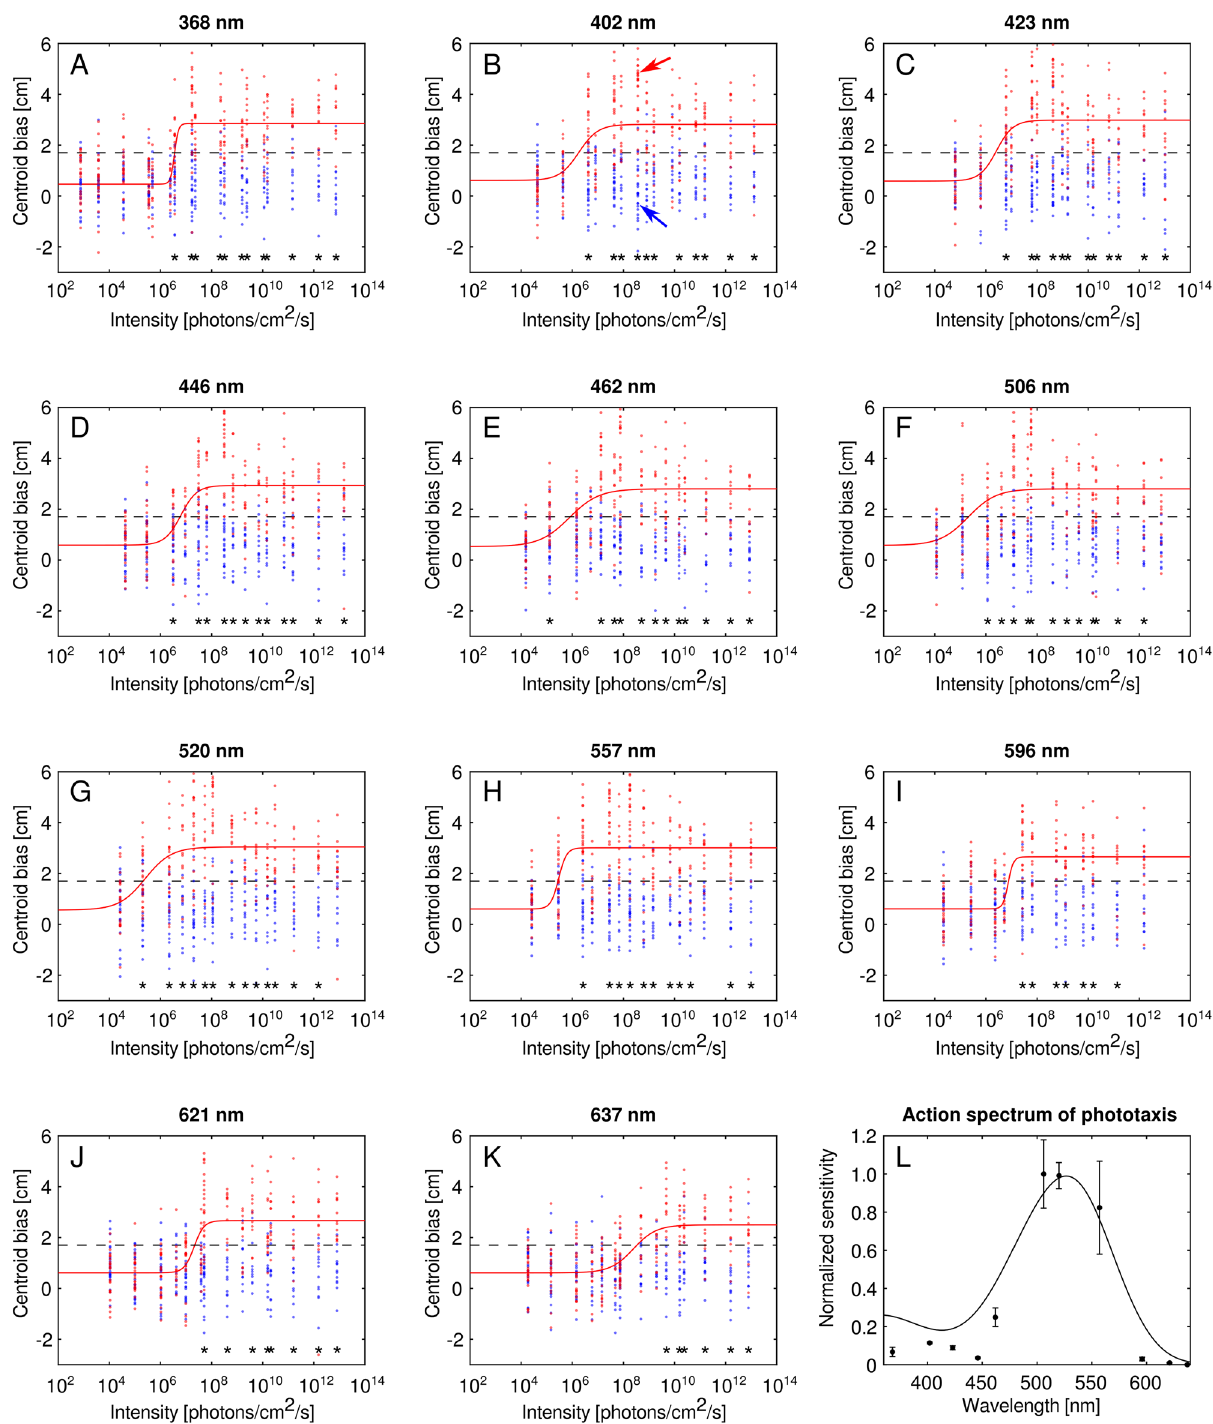
Figure 5. Phototactic responses of L. ingenua in behavioural experiment 1. ( A – K ) Responses with fitted sigmoid exposure-response curves at 11 wavelengths. Blue and red dots represent the centroid bias values (Δ x ) measured at the beginning and end of the applied light stimuli. Sigmoid exposure-response curves were fitted to the Δ x values obtained for the end of the stimuli (red dots). Dashed lines show the critical response criterion (Δ x c = 17.0 mm), and asterisks indicate whether distribution of the Δ x values at the end of a light stimulus (red dots for a given light intensity) significantly differ from the corresponding distribution of Δ x values measured at the beginning of the same stimulus (blue dots for the same light intensity) at α = 0.005 significance level. Red and blue arrows in ( B ) show Δ x values corresponding to Fig. 1E, G and 1F, H, respectively. ( L ) Calculated action spectrum of phototaxis with error bars denoting 95% confidence intervals. Curve shows a fitted A1-based pigment template with a λ max of 526.6 nm 41